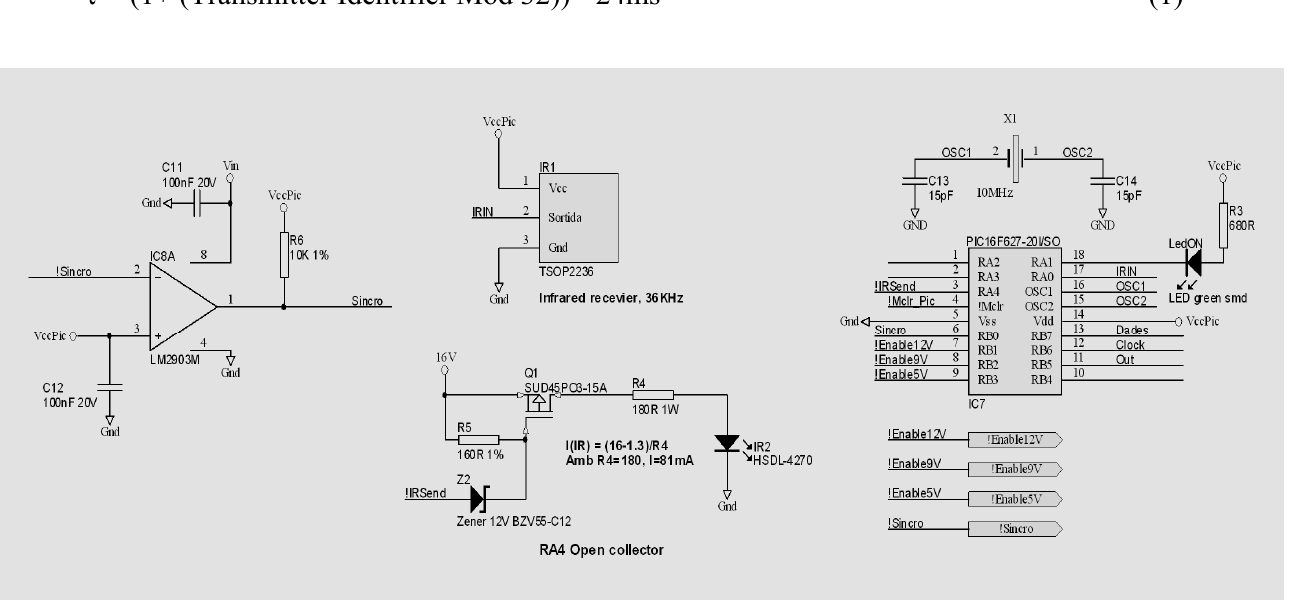
Figure 13 . Control and configuration